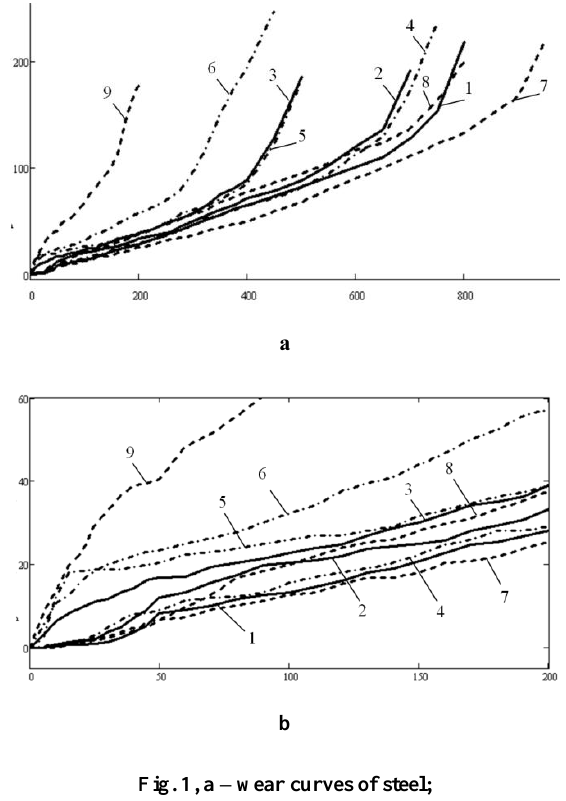
Fig. 1, a – wear curves of steel; b – running-in area of wear curves of nitrided steel 40